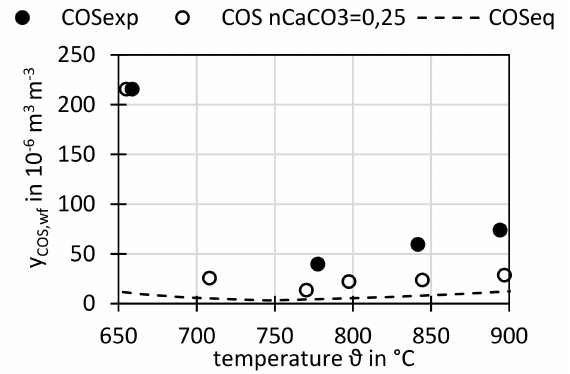
Figure 13. Measured and equilibrium COS concentration on dry and N 2 -free basis at different temperatures ϑ